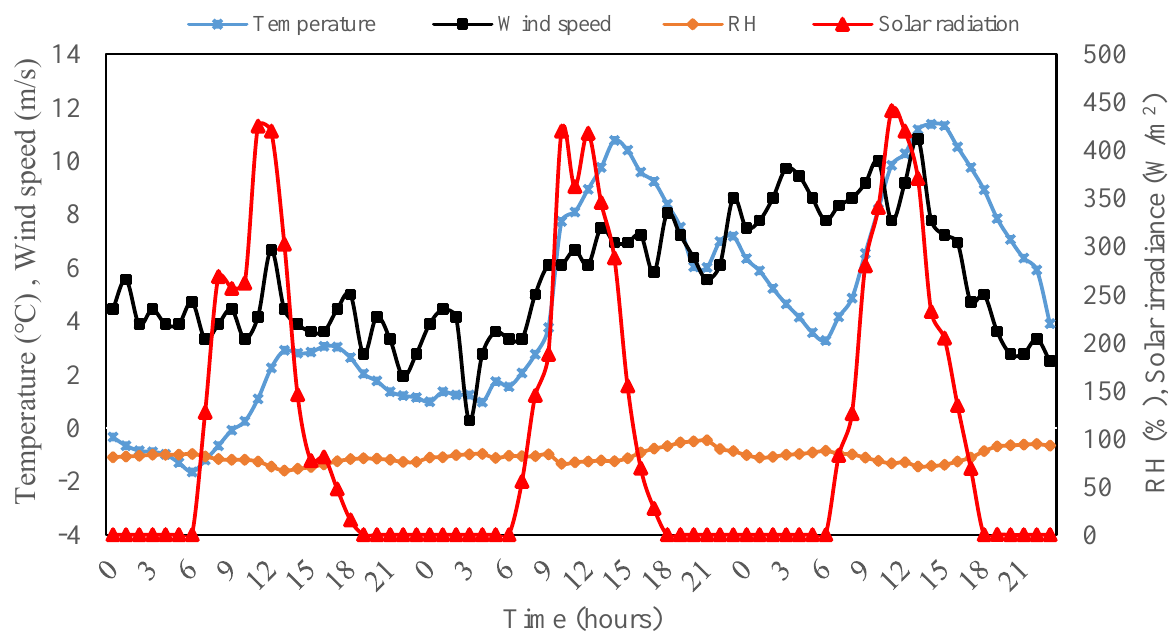
Figure 6. The measured outdoor weather conditions during the experimental period.